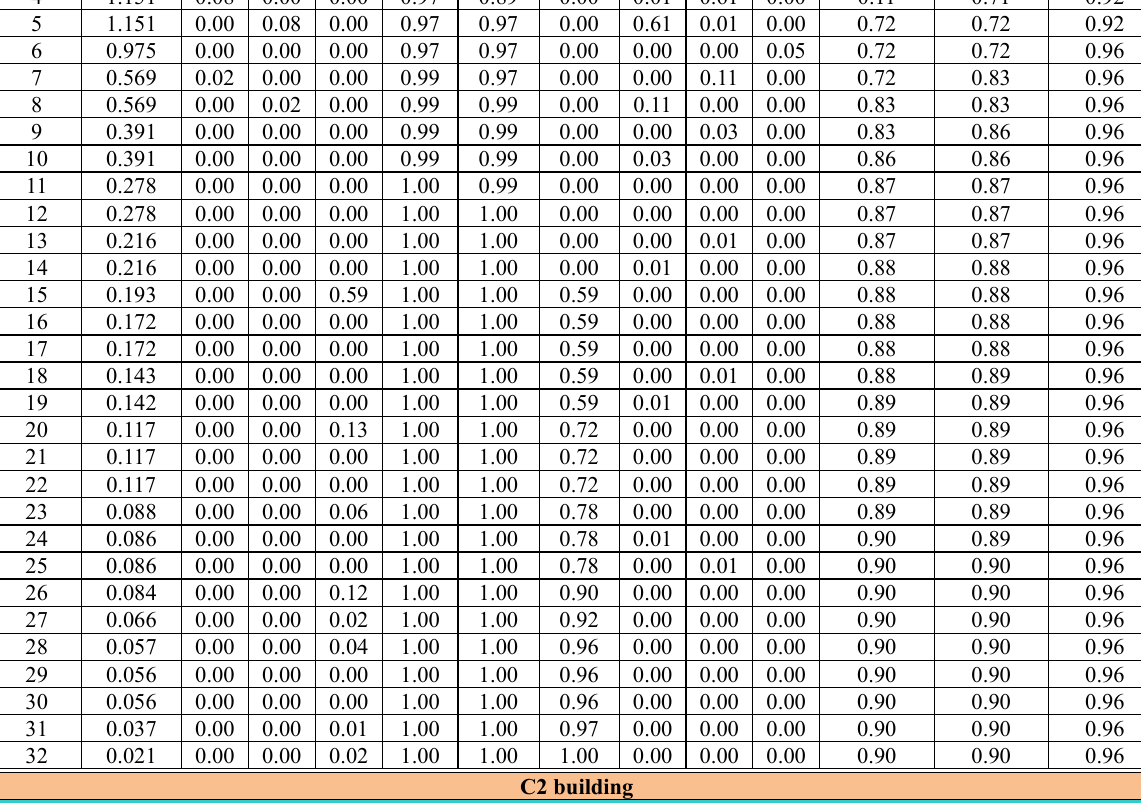
TABLE 1.4 B : Modal Participating Mass